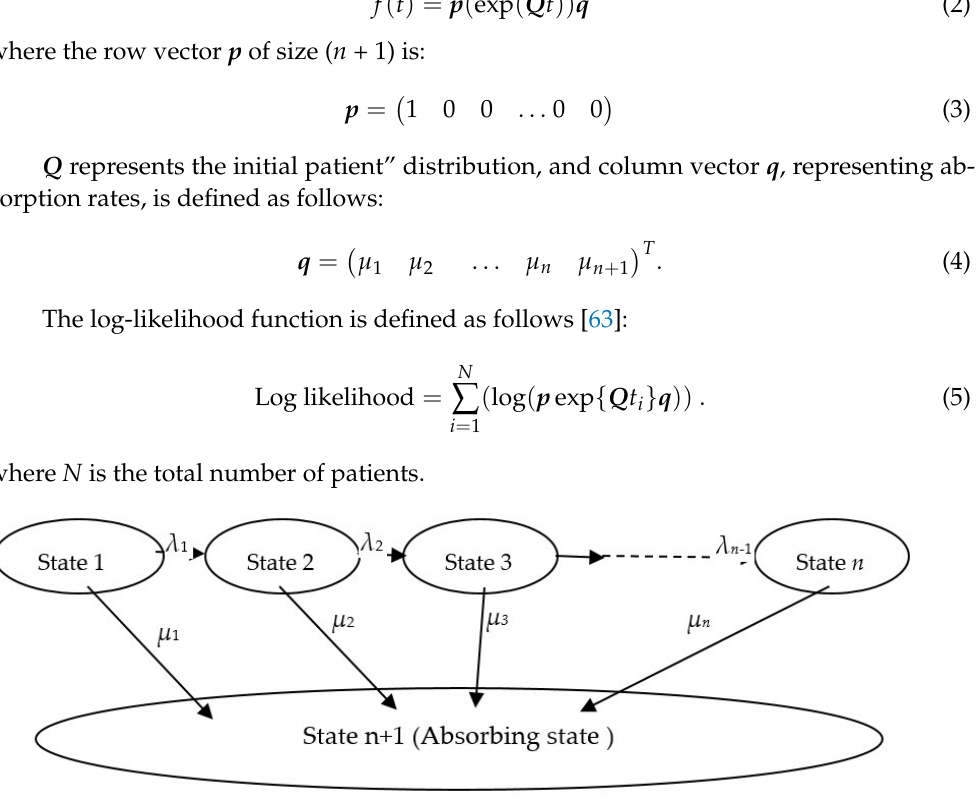
Figure 1. A patient pathway as an n ‐ state absorbing Markov chain.